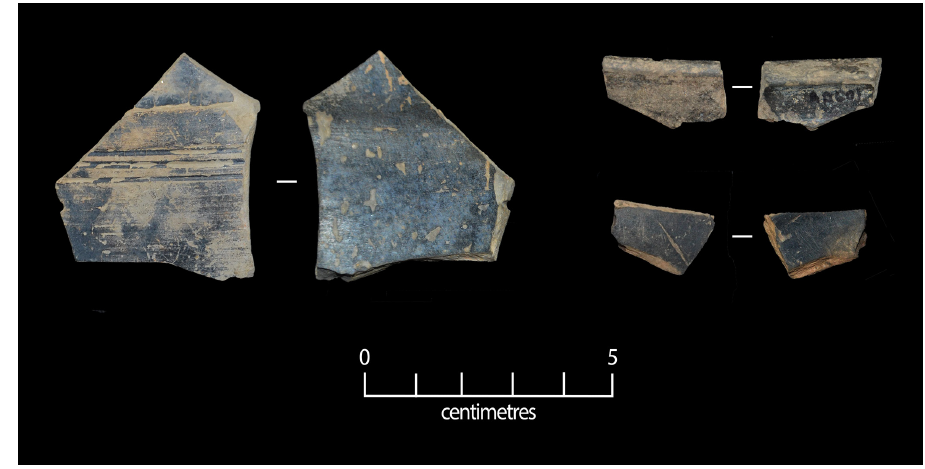
Figure 30: External and internal surfaces of three Class 9 variant 3